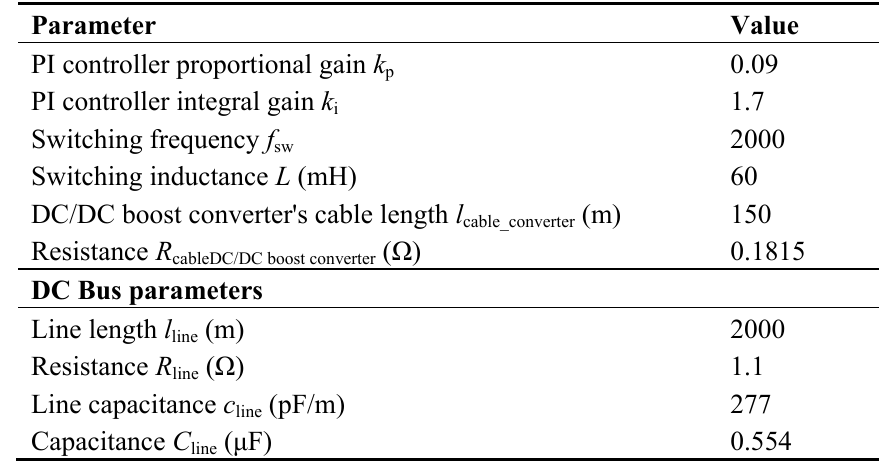
Table 4. Main parameters for each DC/DC boost converter and for the DC